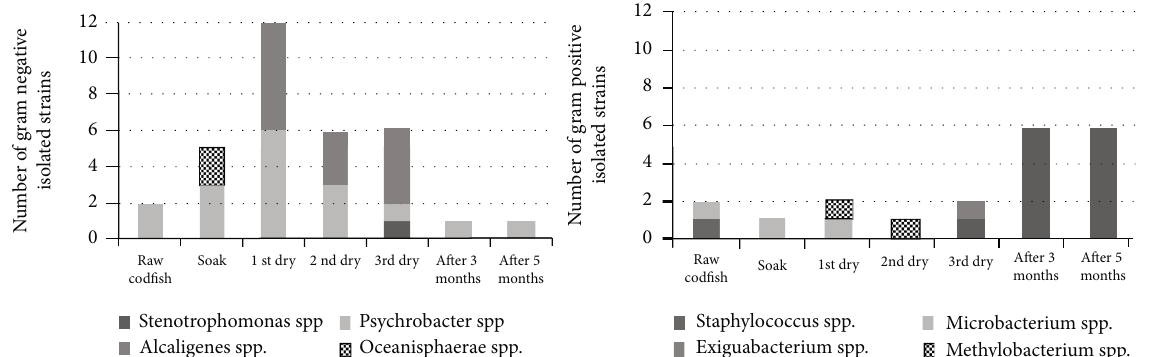
Figure 3: Distribution of the main isolated and identi fi ed Gram-negative and Gram-positive bacteria along the curing process and putrefaction of the yellow cod fi sh.